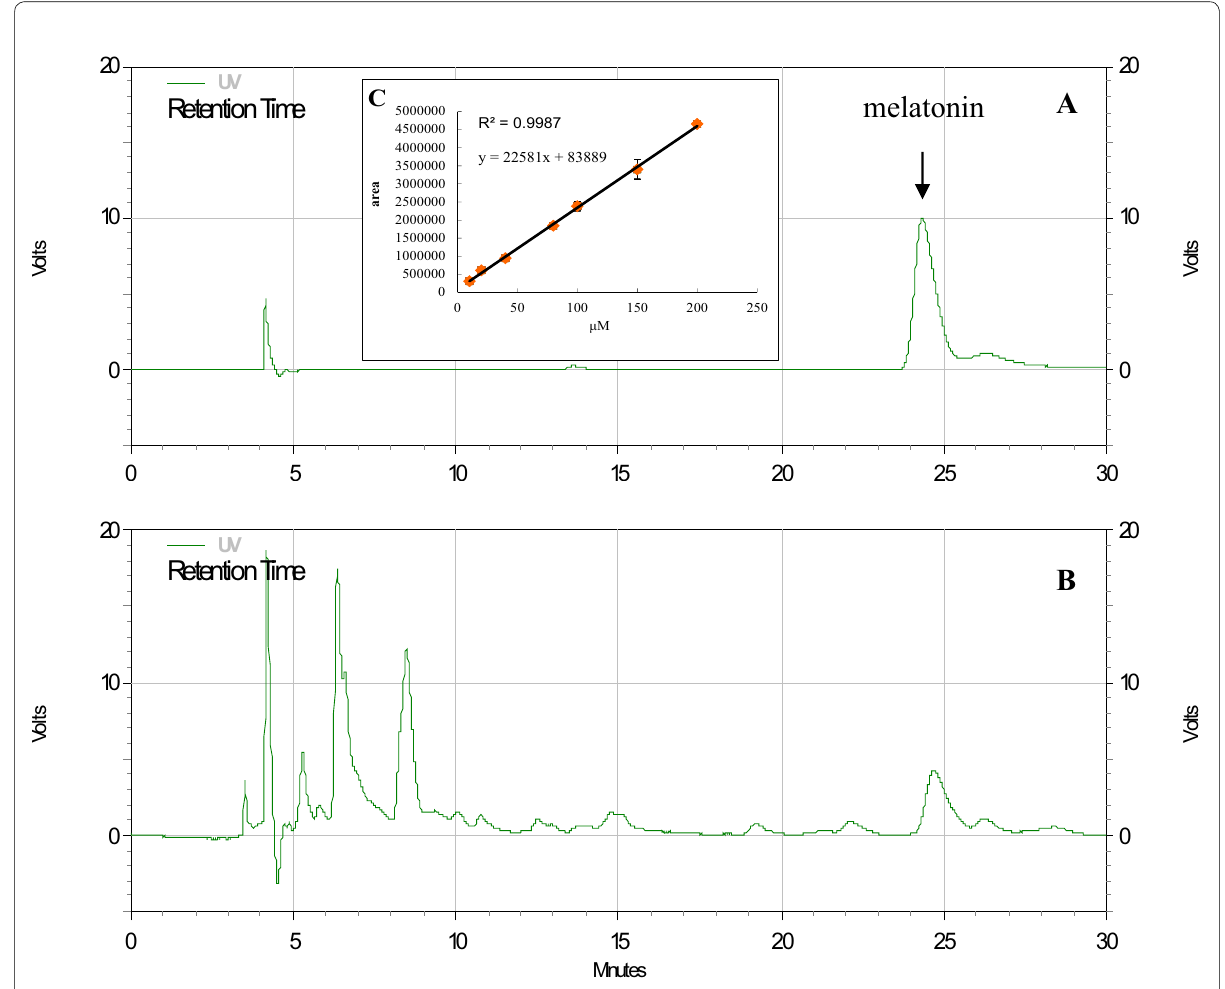
Fig. 1 HPLC analysis for melatonin: a melatonin standard (100 μM), b H. perforatum L. extract, and c calibration curve of melatonin standard. Data are the mean of three